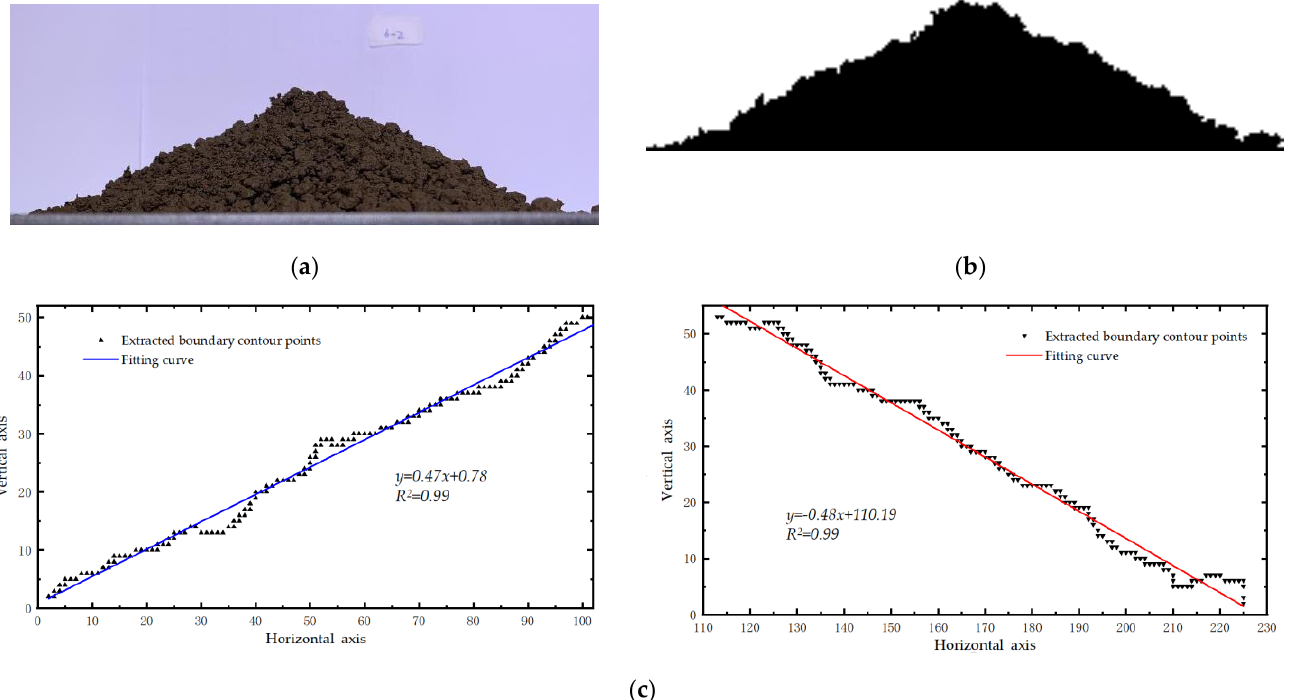
Figure 4. Image processing and fitting process of stacking angle. ( a ) The result of the soil stacking angle obtained from the test. ( b ) The result of the stacking angle after image processing. ( c ) The result of curve fitting after boundary extraction.